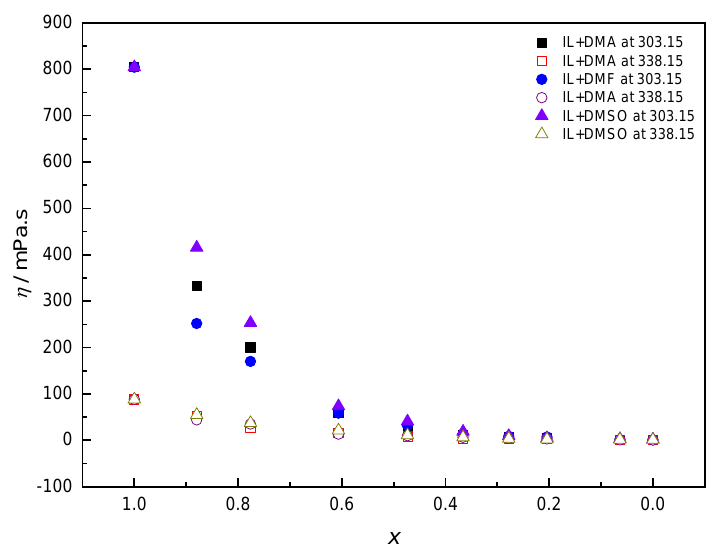
Figure 3. The viscosities of binary mixtures for [C 6 mim] [OAc] with solvents as a function of ionic liquid mole fraction.